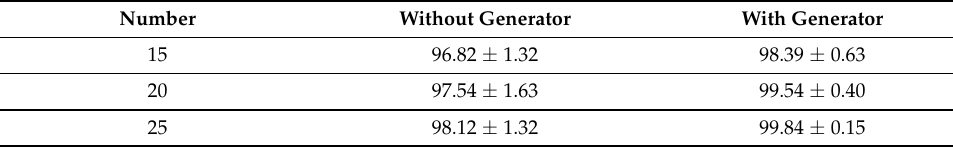
Table 16. The ablation experiments on the Kennedy Space Center (OA)